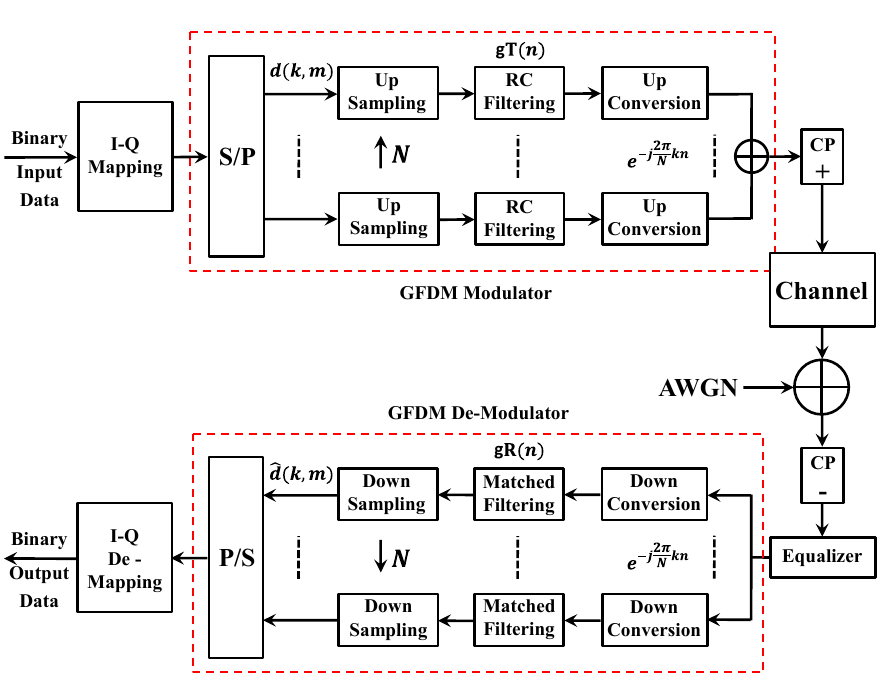
Figure 1. The block scheme of the GFDM waveform transceiver structure.